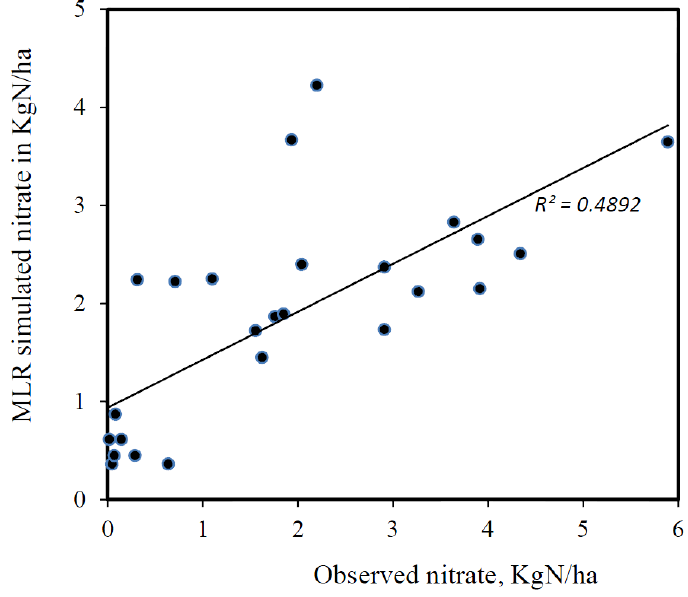
Figure 2. Annual nitrate in surface runoff using Multilinear Regression Model as rainfall and fertilizer as predictors.